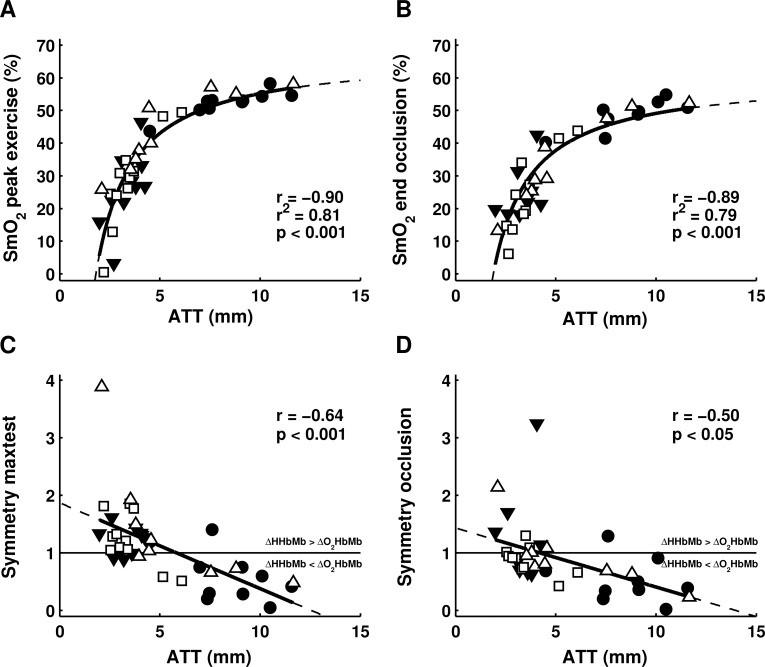
ATT affects SmO2 and symmetry of deoxygenated and oxygenated haemoglobin and myoglobin.Adipose tissue thickness is hyperbolically related to SmO2 at peak exercise (a) and at the end of arterial occlusion (b). Symmetry of (de)oxygenated haemoglobin (ΔHHbMb/ΔO2HbMb) during maximal exercise (c) and from rest to the end of arterial occlusion (d) are linearly related to adipose tissue thickness. Individual values are shown for male cyclists (closed triangle), female cyclists (closed circle), endurance trained males (open square), recreationally trained males (open triangle). Note that occlusion data were successfully obtained in 36 out of 40 subjects.